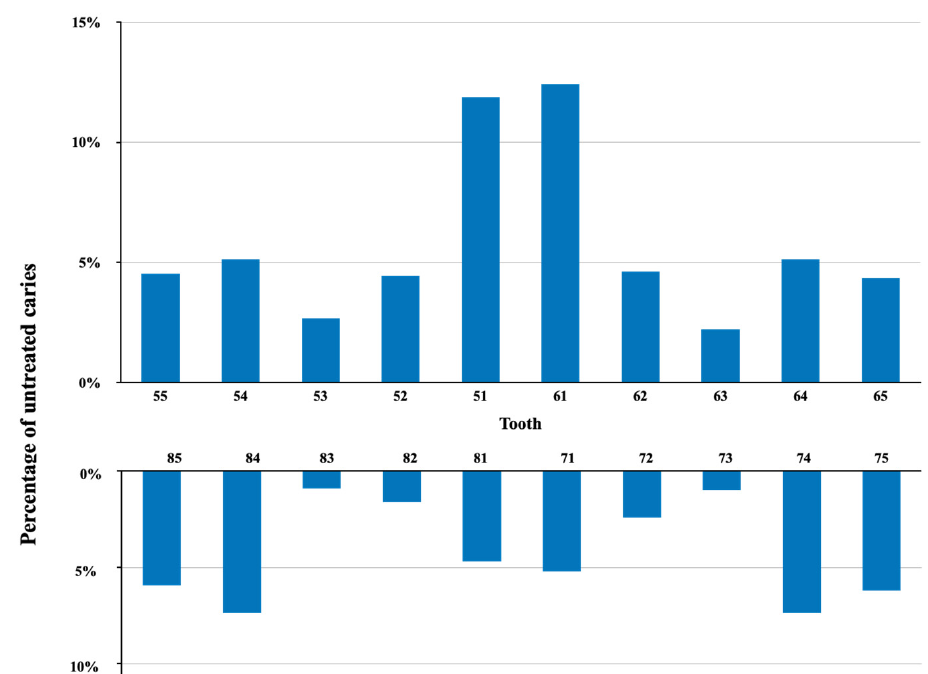
Figure 2. Distribution of untreated ECC index of 5-year-old children in Hong Kong ( n = 404).